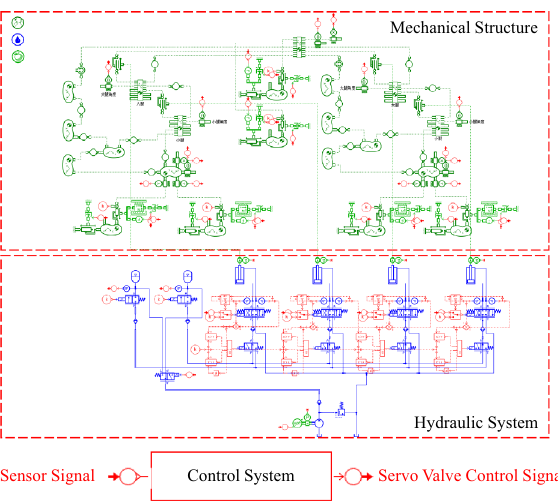
Figure 3. Model of mechanical structure and hydraulic system in AMESim.